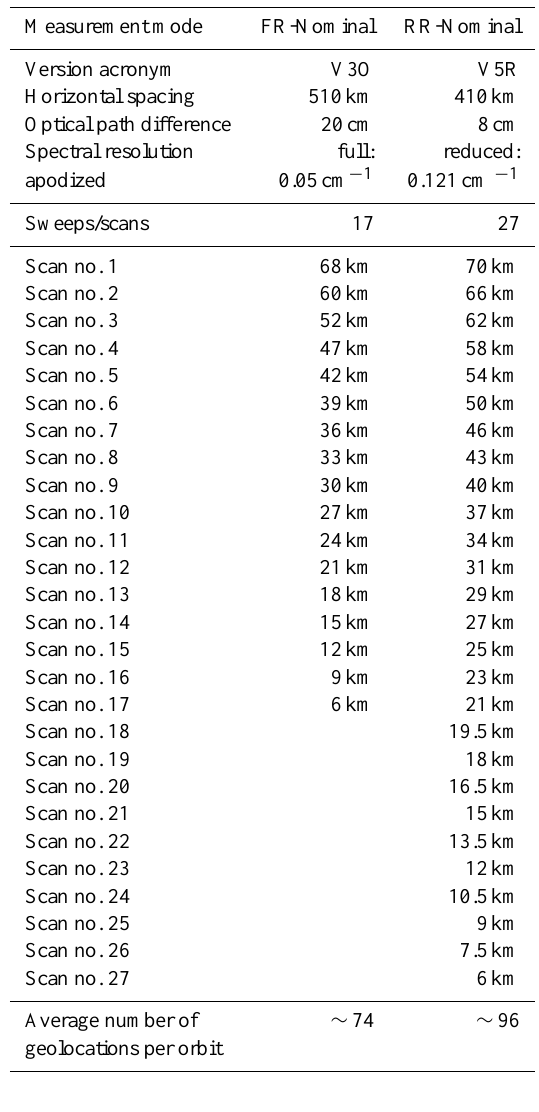
Table 1. Scan sequences for MIPAS FR and RR measurements (Dudhia, 2012). The RR-Nominal mode heights are latitude depen-